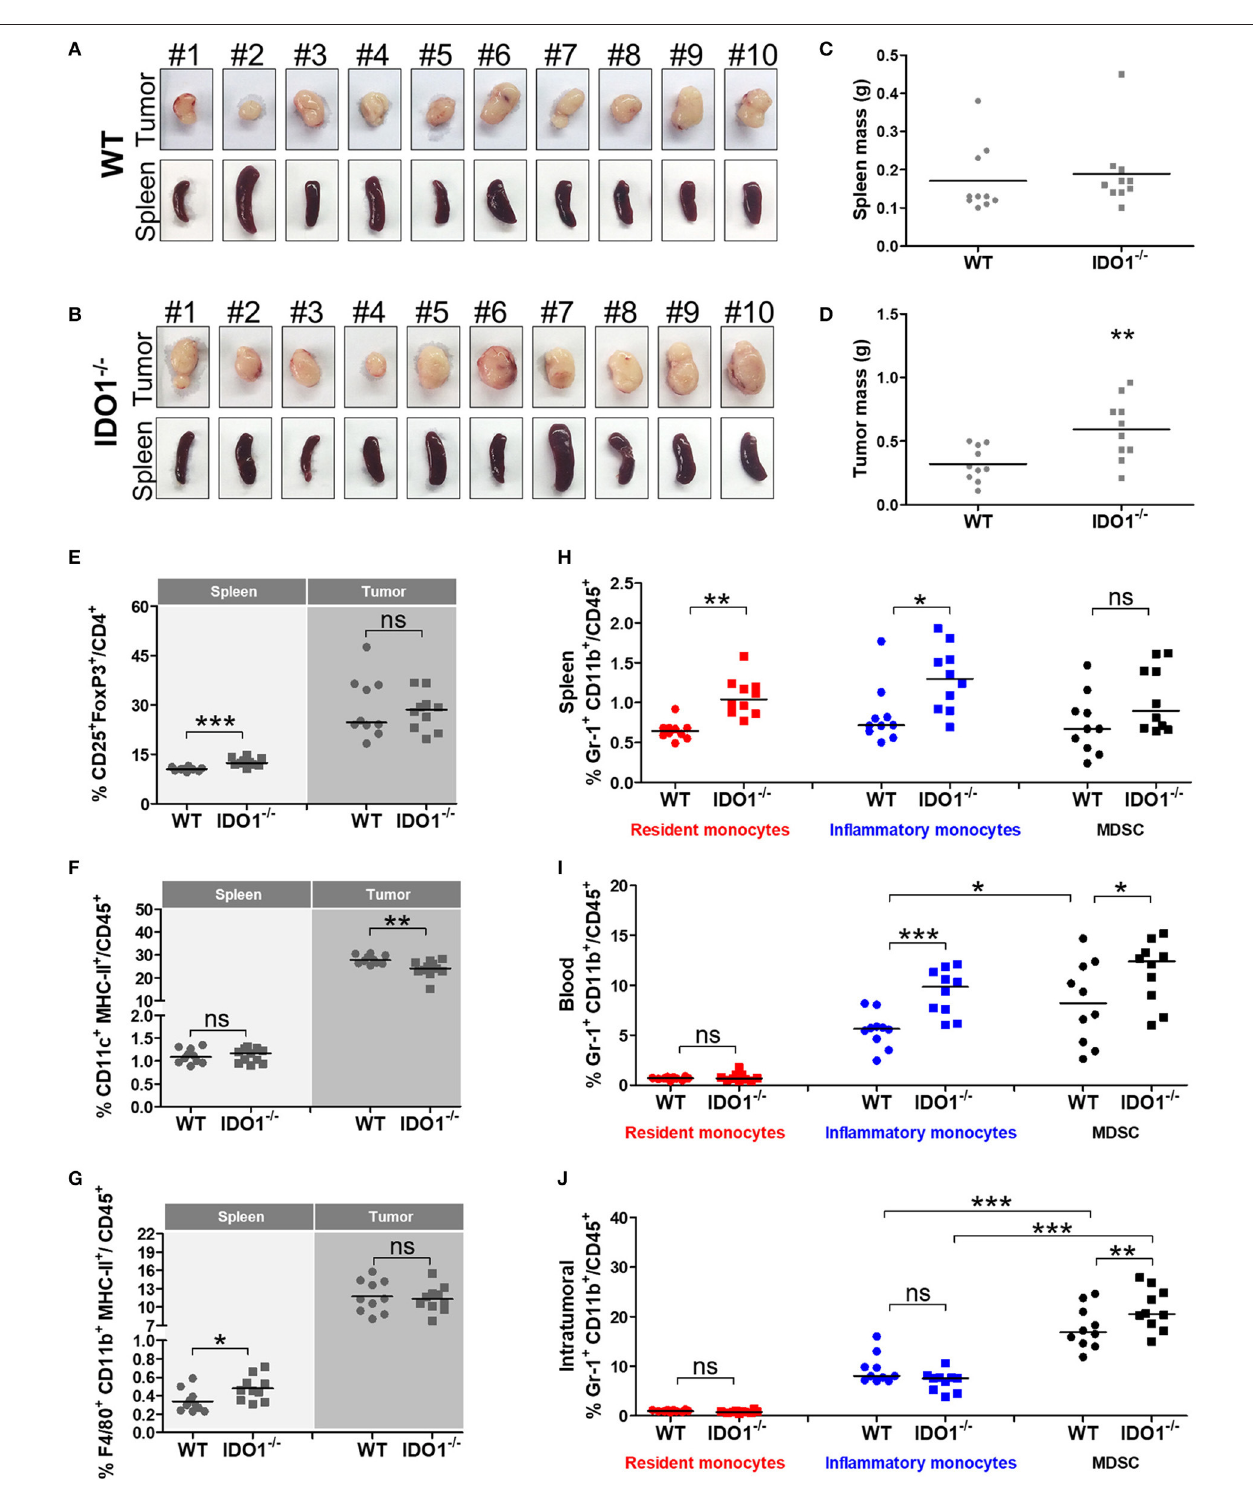
FIGURE 3 | The absence of IDO1 expression modifies the frequency of immunological cells in distinct mice tissues. Images of tumor masses and spleen from wild-type (WT) (A) and IDO − / − (B) mice subcutaneously injected with 1 × 10 5 TC-1 cells and euthanized 21 days later ( n = 10 per group). Comparative analyses of (C) spleen and (D) tumor masses of WT and IDO − / − mice. Comparative analyses of (E) Treg, (F) DCs and (G) macrophages in spleens and tumor tissues of WT and IDO − / − mice. Comparative analyses of resident monocytes, inflammatory monocytes and MDSC in (H) spleens, (I) blood and (J) tumor tissues of WT and IDO − / − mice. Statistical significance: * p < 0.05, ** p < 0.01, and *** p < 0.001 by ANOVA or unpaired Student’s t -test. (ns) Non-significant.